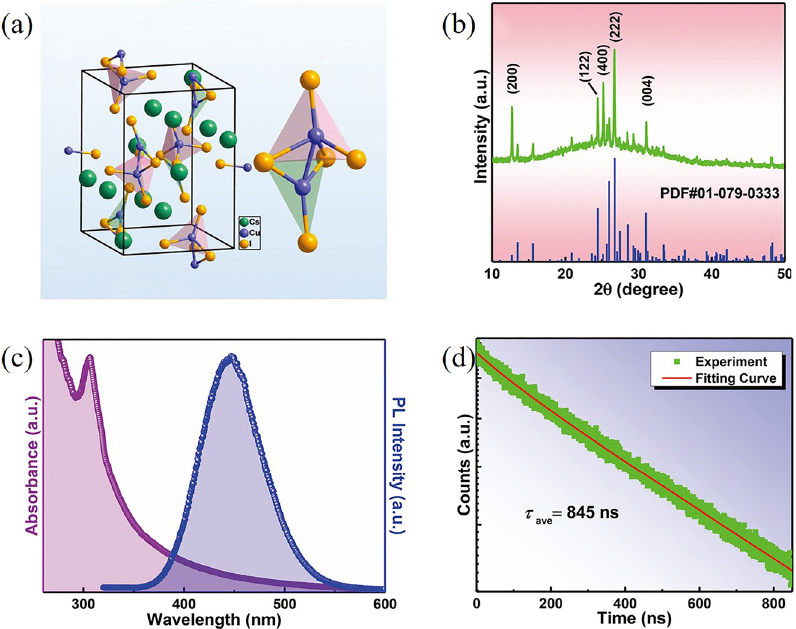
Cu I , the 3 2 5 Cu I 3 2 5